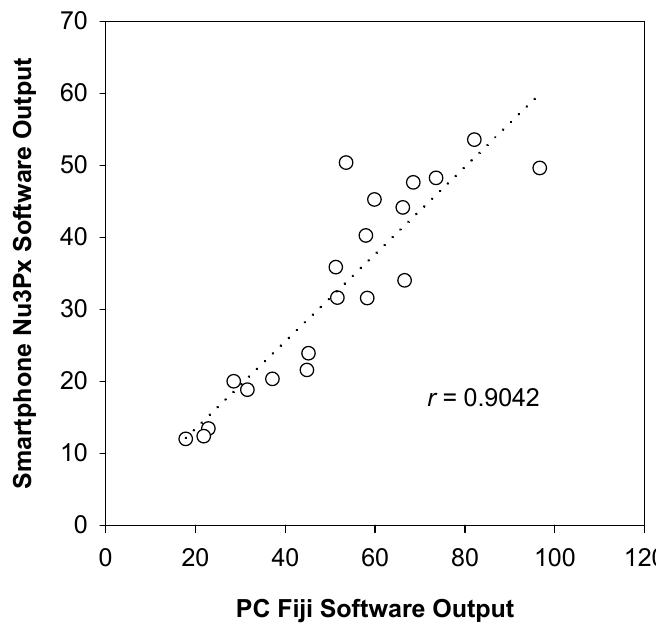
Figure 7. Method comparison plot of several samples of corn spiked with ferrous fumarate analyzed via two methods, as follows: The computer-based Fiji software and the smartphone-based Nu3px app. Data are means of five spike levels (µg Fe/g flour) measured four times with either software analysis tool.